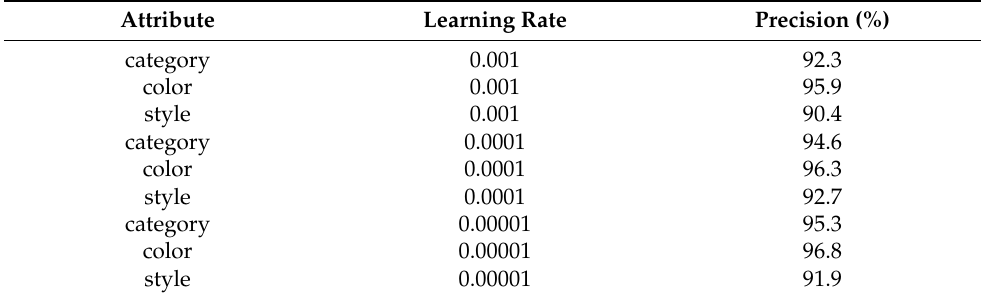
Figure 9. Comparison of classification accuracy between MCNN and dual-channel convolutional neural network. Table 9. Performance of MCNN classification results.